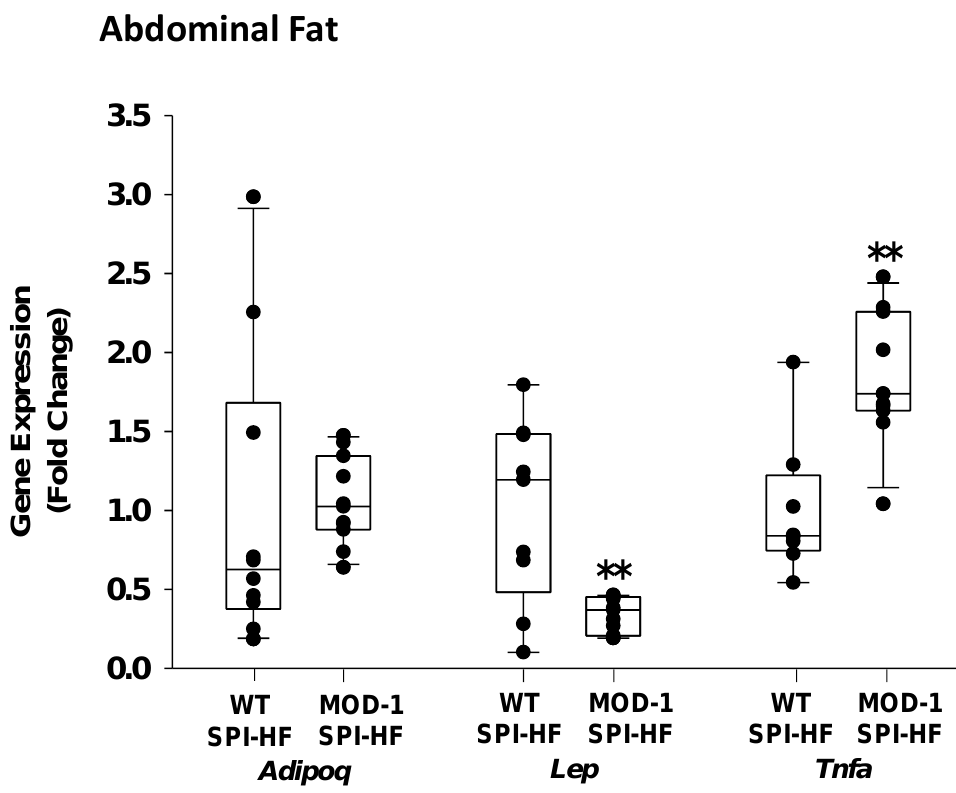
Figure 6. Effects of Me1 mutation on abdominal fat adiponectin ( Adipoq ), leptin ( Lep ), and tumor necrosis factor α ( TNFα ) mRNA abundance in female mice ( n = 10 WT; n = 11 MOD-1) who were fed a SPI-HF diet. qPCR used Actb and Tbp as normalizers, followed by application of geNorm, as de- scribed previously [25]. Box plots indicate the upper and lower quartiles, interquartile range, and median (middle line), with whiskers showing maximum and minimum points within 1.5 × the in- terquartile range. ** p < 0.01.